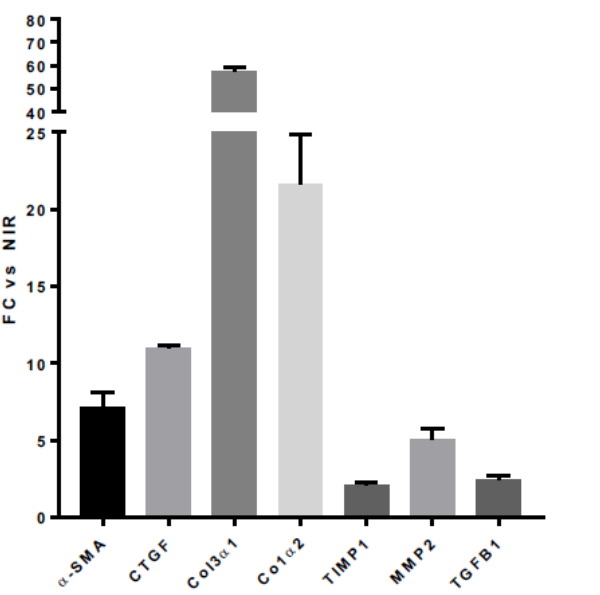
Figure 5. Results of the expressions of genes involved in fibrosis in irradiated HUBFs (3 × 3.5 Gy) at D5 post irradiation compared to non-irradiated HUBFs. The results were normalized to the untreated HUBFs. Gene expression profile of HUBFs after irradiation compared to non-irradiated control (NIR). FC: Fold change. The mRNA level of GAPDH gene was considered as normalizing control gene. Fold change values were evaluated using the following formula: 2 − ∆∆ Ct , n = 6.